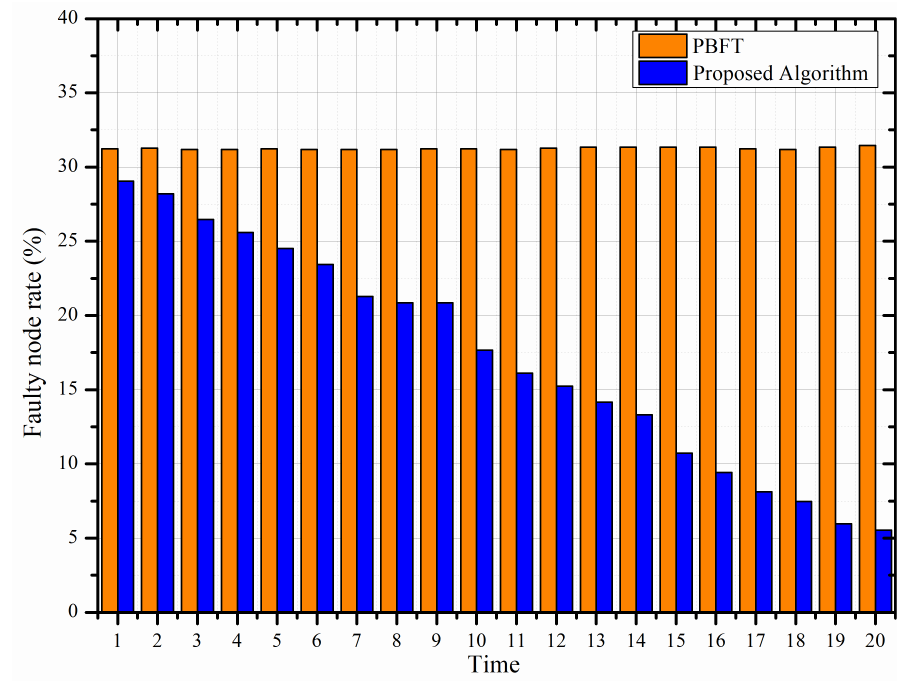
Figure 9. Faulty node rate.